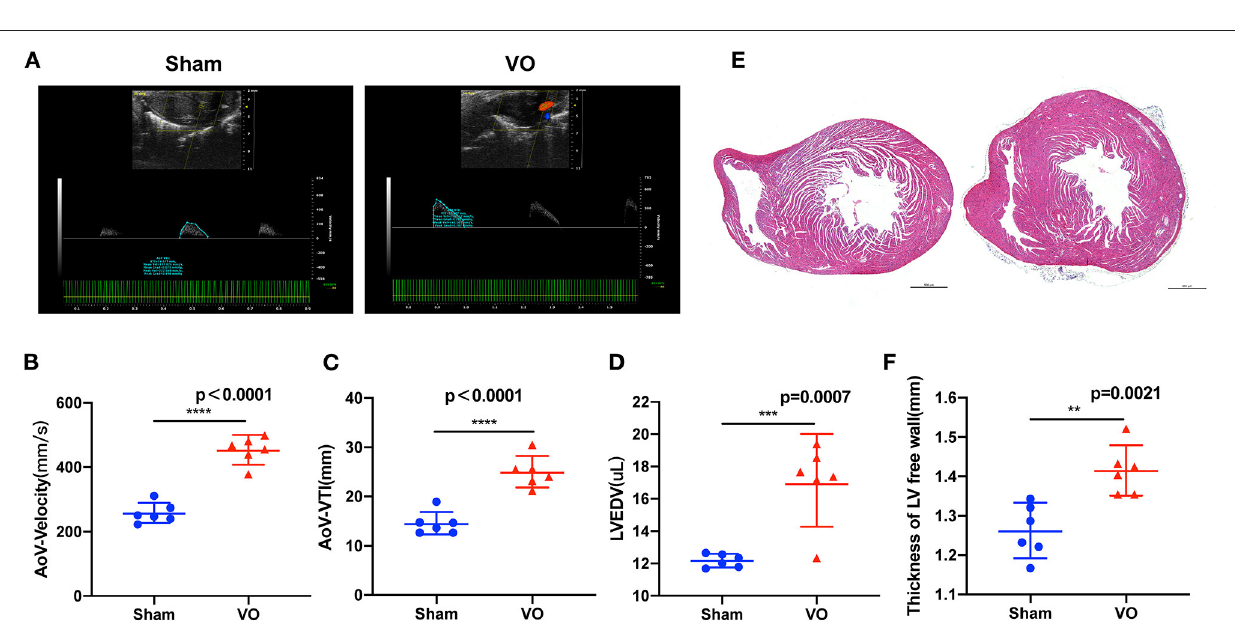
cardiac phenotype. These results confirmed that the LV VO was successfully established in ACF mice, consistent with previous publications (24,